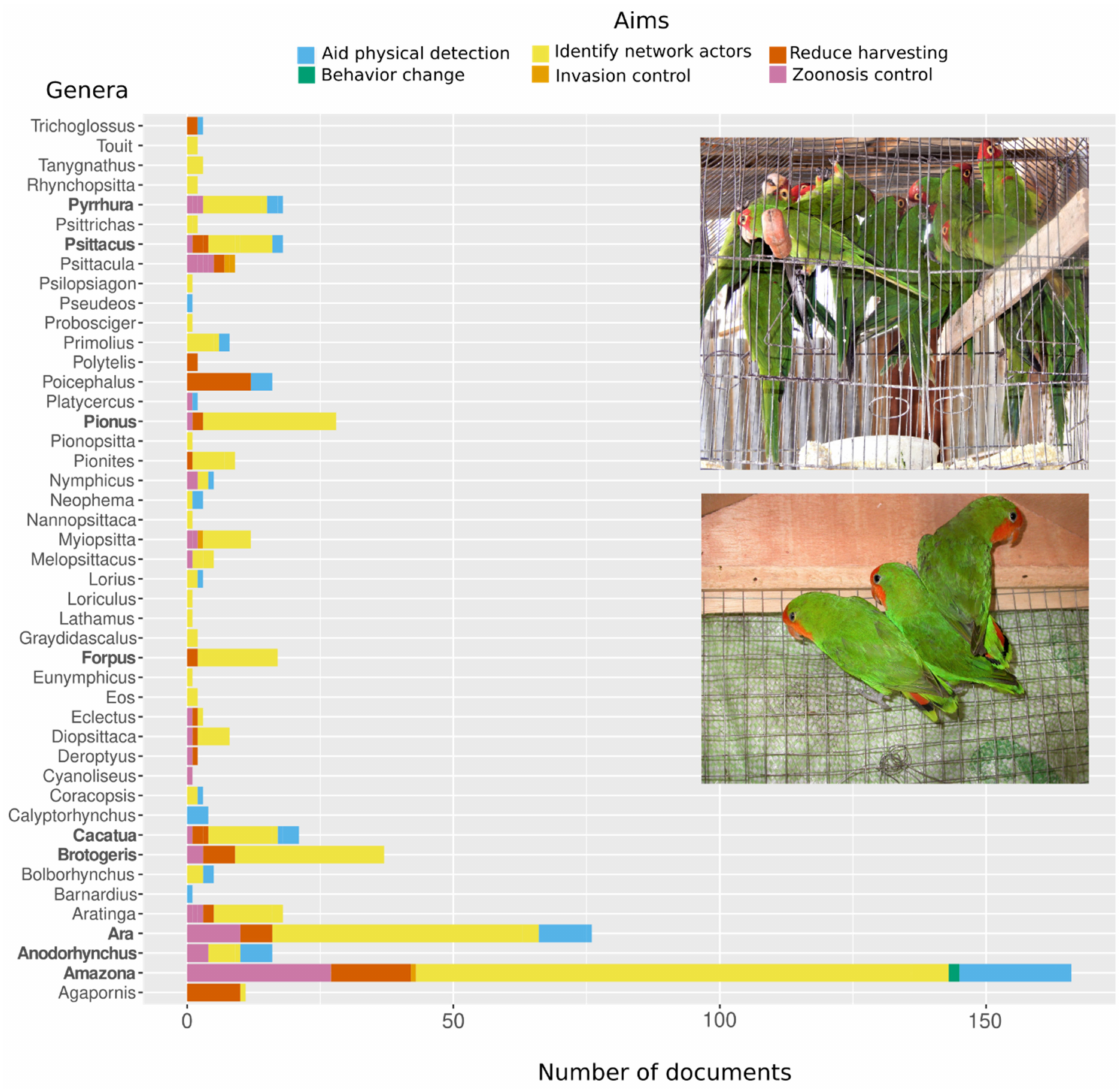
Figure 3. Taxonomic pattern in conservation aims in the published illegal parrot trade literature. The number of documents by genus and aim are shown. The top 10 most studied genera (with more than 10 documents published) are in bold. Genera are in alphabetical order from bottom to top. The former genus Aratinga , as reported in the literature, currently comprises four different genera ( Aratinga , Eupsittula , Psittacara , and Thectocercus ). Insert: red-masked parakeets ( Psittacara erythrogenys , top) and red-faced lovebirds ( Agapornis pullarius , bottom) involved in the domestic and international illegal trade in Peru and Senegal, respectively (Pictures: Jos é L.